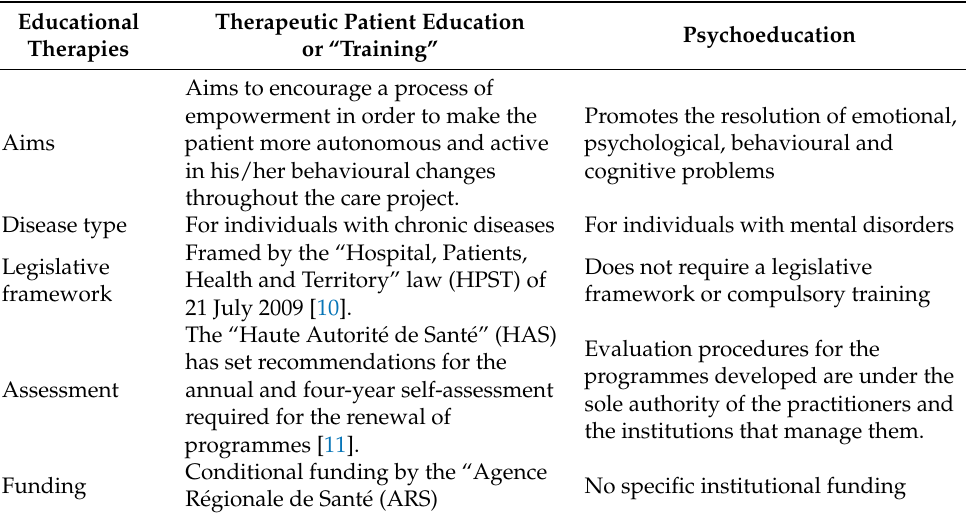
Table 1. A comparison between therapeutic patient education or “training” and psychoeducation in